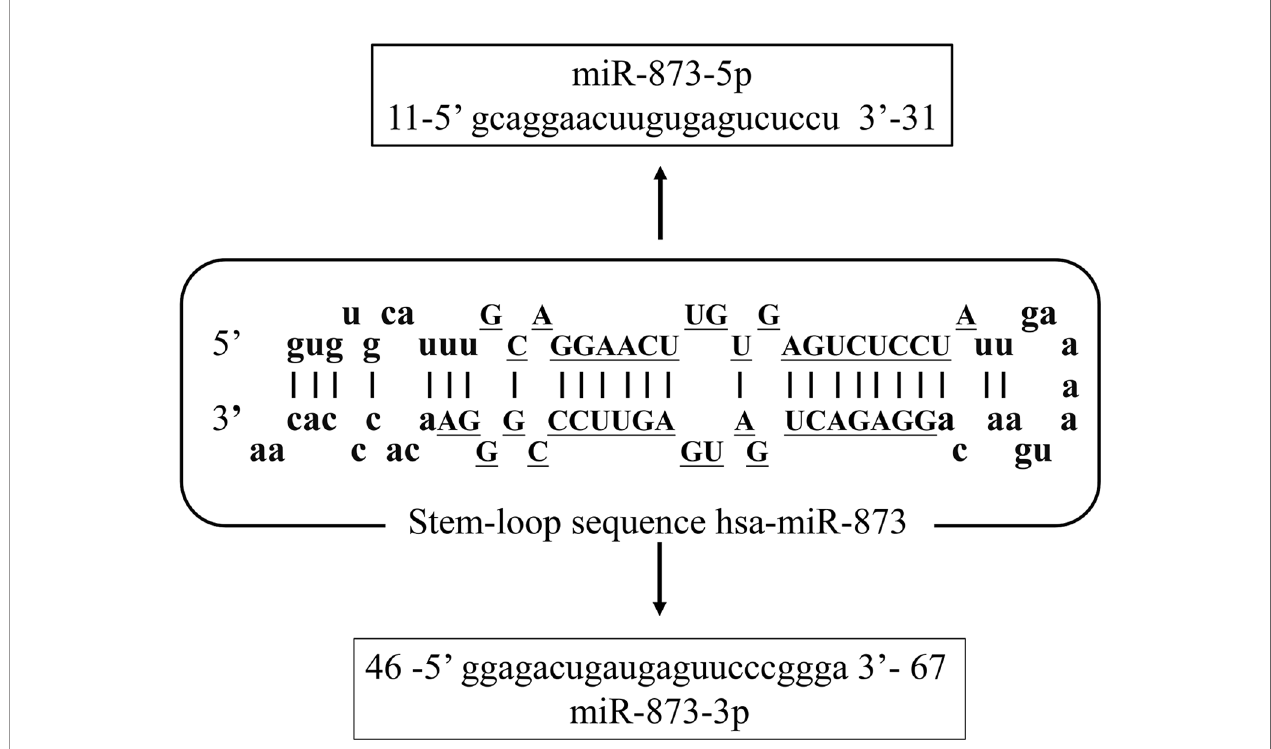
FIGURE 1 | The sequence structure of the miR-873 family. Hsa-mir-873 is located on chromosome 9 (chr9:28888878-28888954). It has two mature sequences, hsa-miR-873-5p (MIMAT0004953, miR-873-5p) and hsa-miR-873-3p (MIMAT0022717,